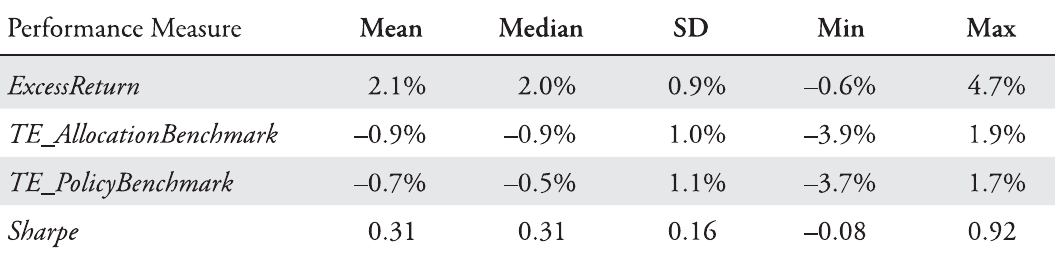
Table 11: Descriptive Statistics of the Performance